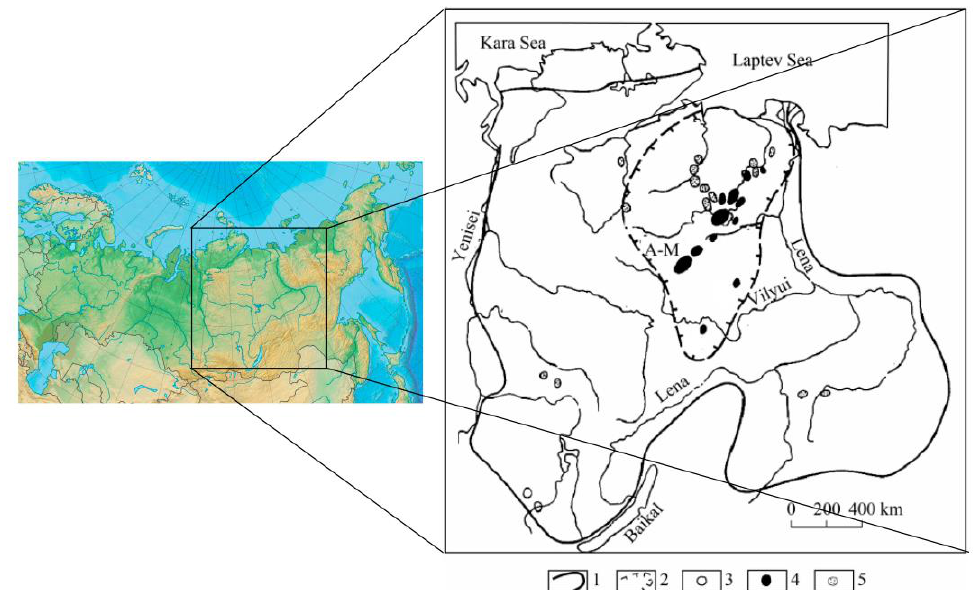
Figure 1. Map of Russia and the distribution of kimberlite rocks on the Siberia platform [2]. 1 — Siberia platform boundary, 2 — Yakutia kimberlite province boundary, 3 – 5 — kimberlite fields of lower (3) and middle (4) Proterozoic and Mesozoic (5) age. A – M — Alakit-Markha kimberlite field (results of surveys in this field are considered in this paper).